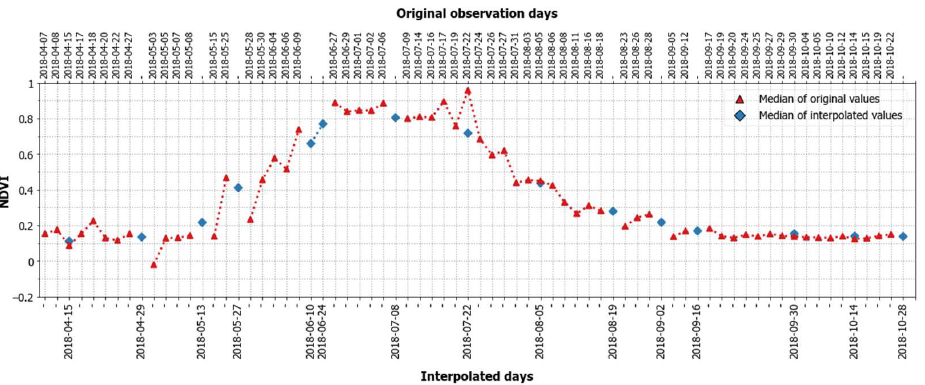
Figure 3. NDVI profile of original and interpolated values for the class potatoes (500 sample points) in tile